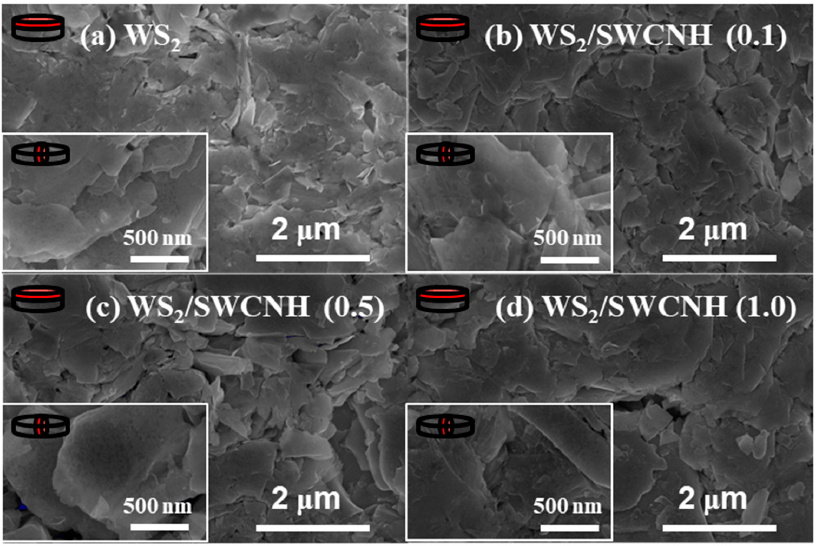
Figure 3. FE-SEM images of as-sintered ( a ) WS 2 , ( b ) WS 2 /SWCNH(0.1), ( c ) WS 2 /SWCNH(0.5), and ( d ) WS 2 /SWCNH(1.0).